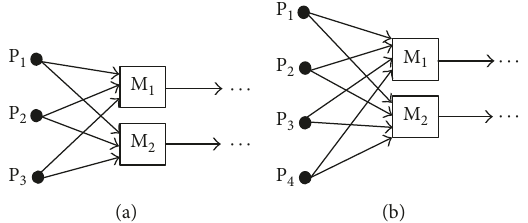
Figure 7: MPC consisting of (a) two machines and three parts and (b) two machines and four parts.